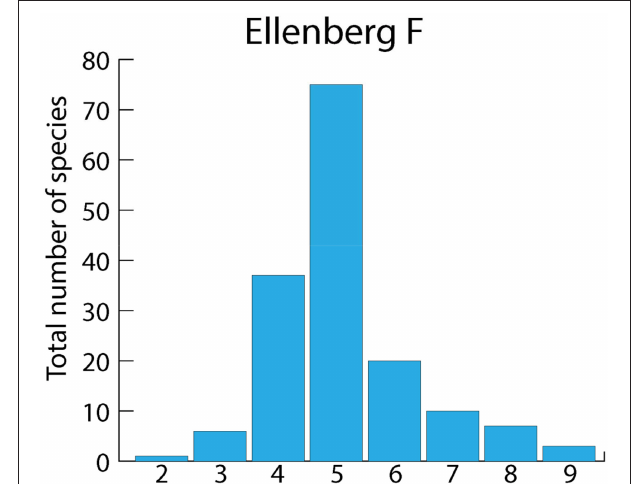
FIGURE 7 | Relative frequencies of Ellenberg moisture indicator values (F) for plant taxa dispersed by corvids through endozoochory, according to Heintze’s complete list. N = 150 taxa (excluding seven species with an unknown F value, see Table S1 ). This scale goes from 1 (dry soils) to 12 (submerged macrophytes). Plants with F ≥ 10 can be considered aquatic.